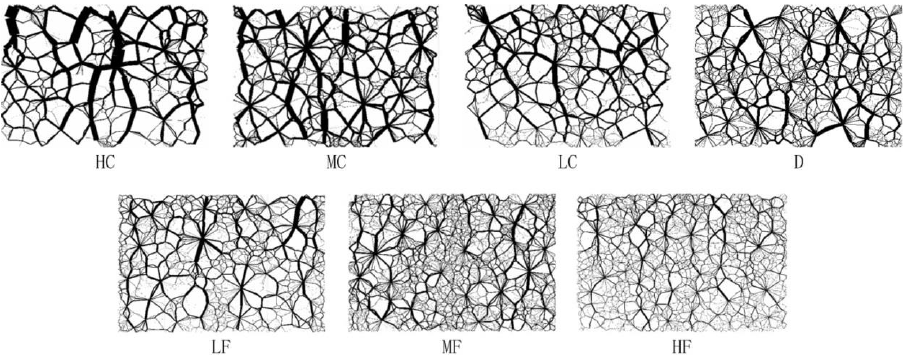
Figure 6. Distribution of contact force in asphalt mixtures.